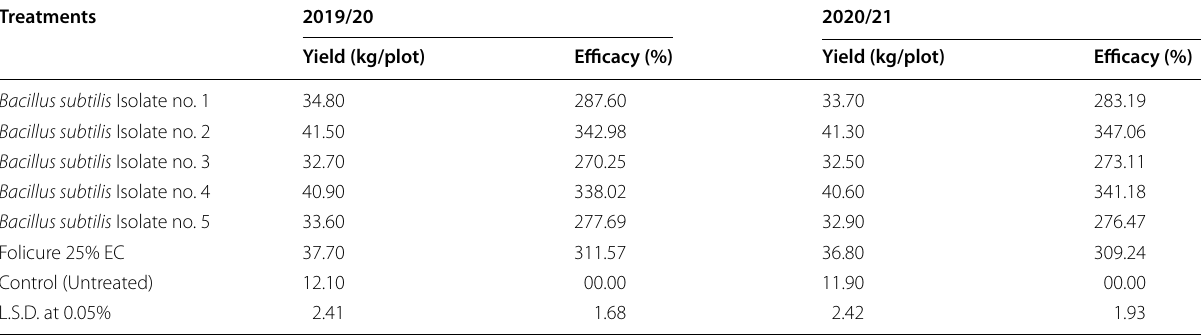
Table 4 Effect of Bacillus subtilis and Folicure treatments on onion yield under field conditions at Mallawi, Menia governorate,